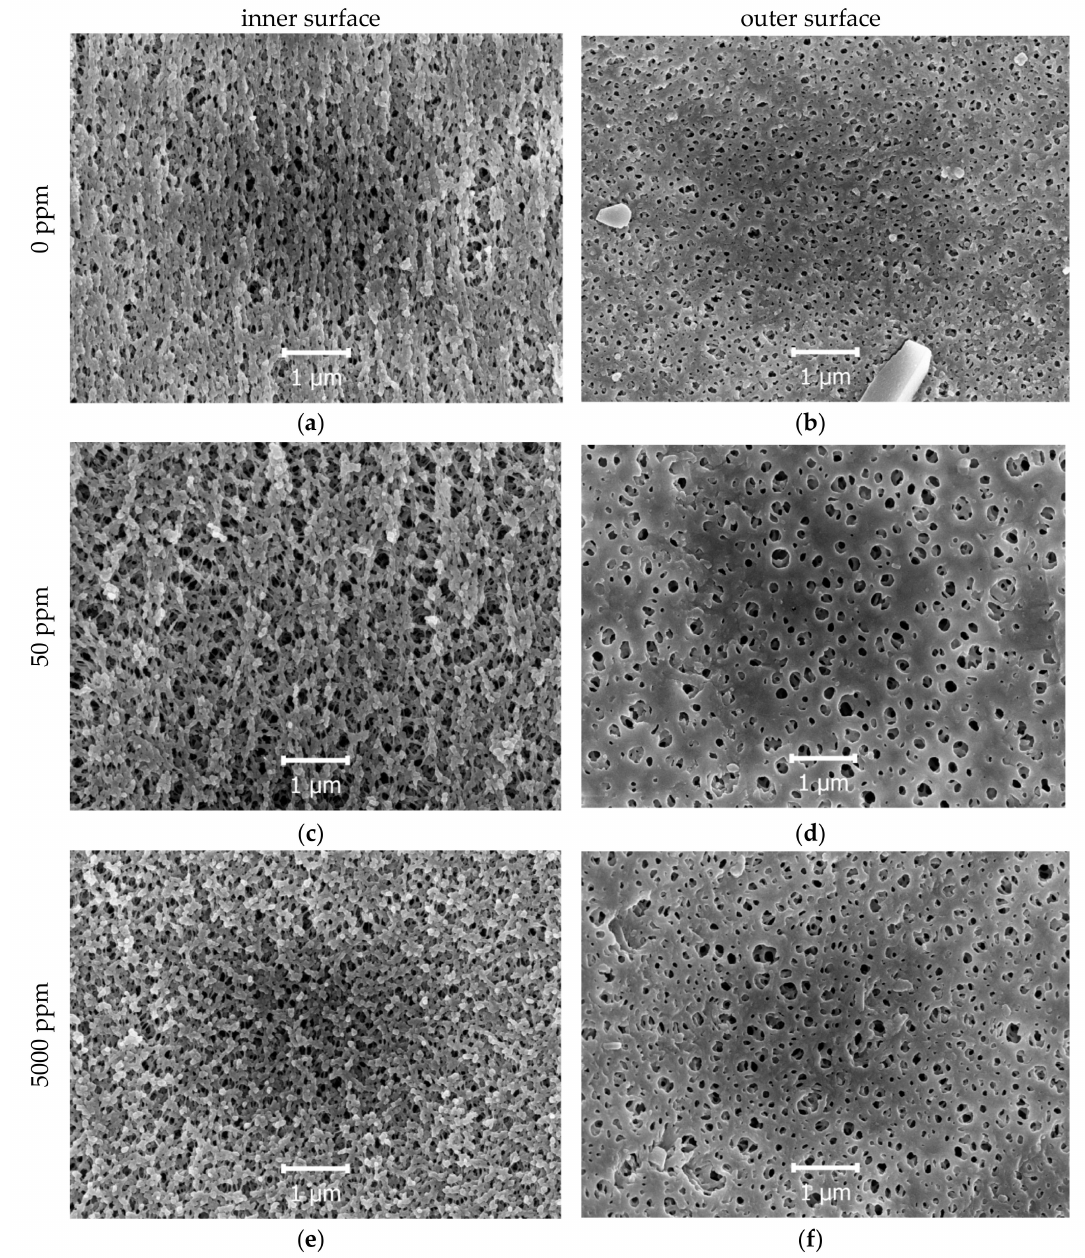
Figure 3. SEM micrographs of the untreated membrane (0 ppm, ( a )—inner surface, ( b )—outer surface) and membranes treated with solutions with active chlorine concentrations of 50 ppm (( c )—inner surface, ( d )—outer surface) and 5000 ppm (( e )—inner surface, ( f )—outer